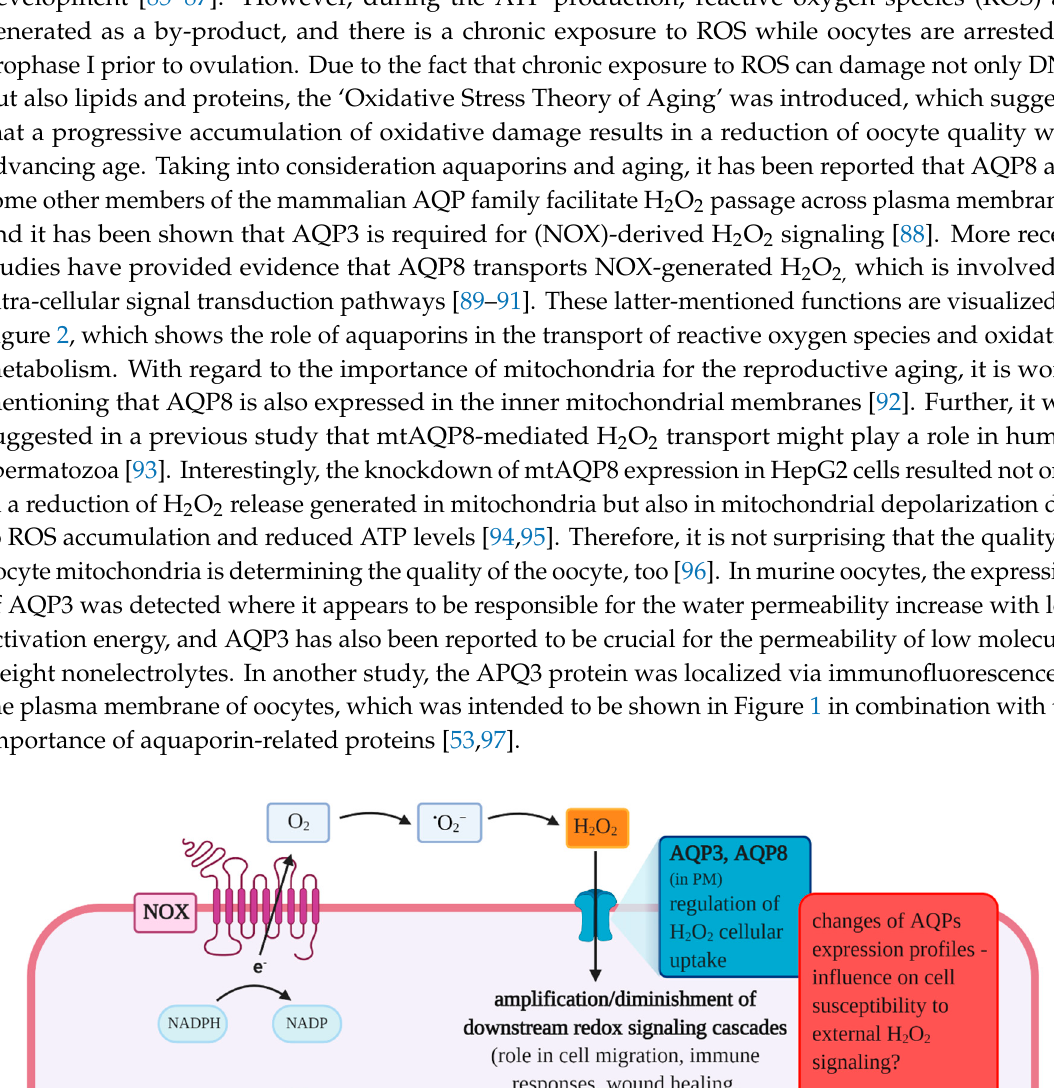
Figure 2. The role of aquaporins in the transport of reactive oxygen species and oxidative metabolism. The main physiological sources of reactive oxygen species include: mitochondria, nicotinamide adenine dinucleotide phosphate oxidase, xanthine oxidase and lipoxygenases. AQP3 and AQP8 belong to the family of aquaporins and can be classified as aquaglyceroporin and orthodox aquaporin, respectively. A growing body of research has demonstrated the involvement of these two membrane channels